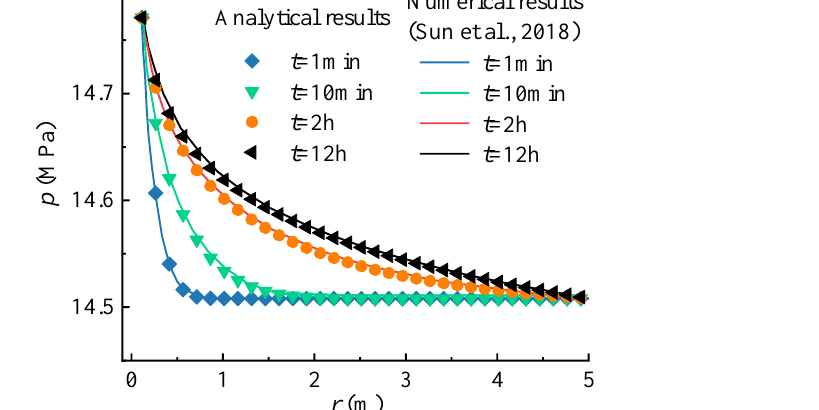
Figure 6. Comparison between the results from the model in this paper and the numerical one (Sun (Sun et al., 2018) [44] of the pore pressure versus distance from the wellbore wall for different